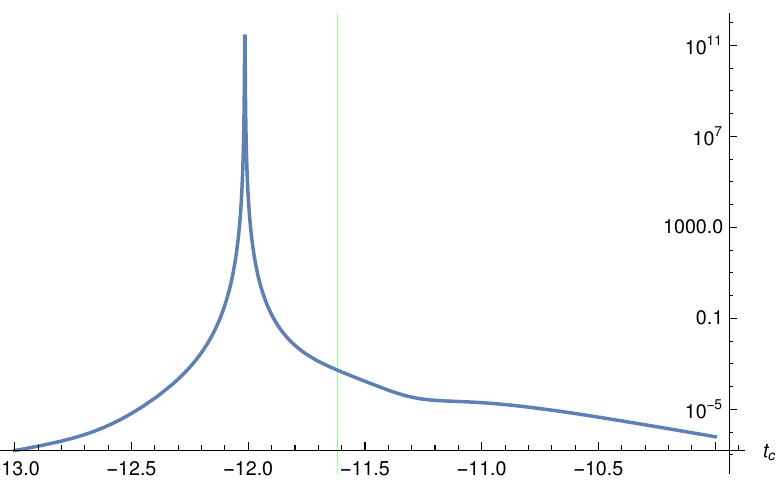
Figure 12. The Kretschmann scalar for the case α 1 (cid:54) = 0 with Ω c < 0. In particular, the parameters are chosen as m = 10 6 , ( ω cc , ω cb , Ω c ) = ( − δ c given by Equation